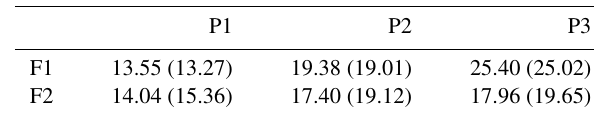
Table 5. Cumulative root water uptake simulated by the Couvreur model using root hydraulic conductance ( K rs ) obtained from the silty soil (F2) for the stony soil (F1) and using K rs obtained from the stony soil for the silty soil. P1, P2, and P3 are the sheltered, rain- fed, and irrigated plots. Values in parentheses are simulated RWU using the optimized parameters from measured SWC and SWP in the respective